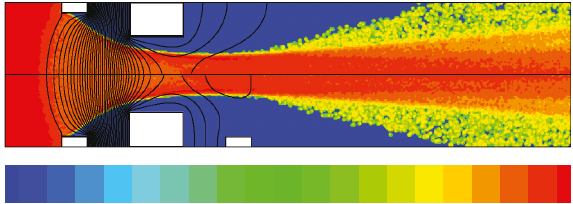
Figure 3: Beam distribution without CEX n